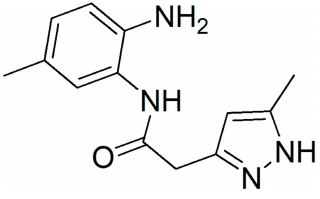
extending along the a -axis direction (Fig. 2). The chains are